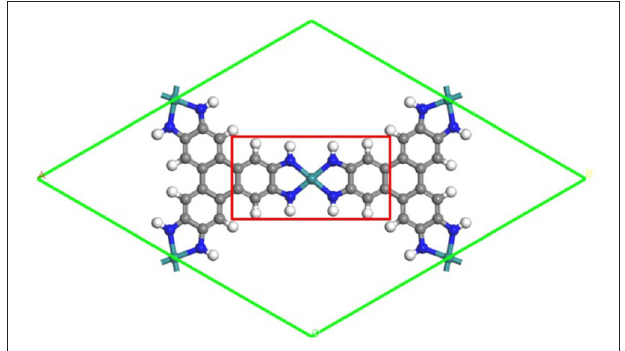
FIGURE 1 | The schematic structure of the TM 3 (HITP) 2 monolayer. Green, blue, gray, and white denote the TM, N, C, and H